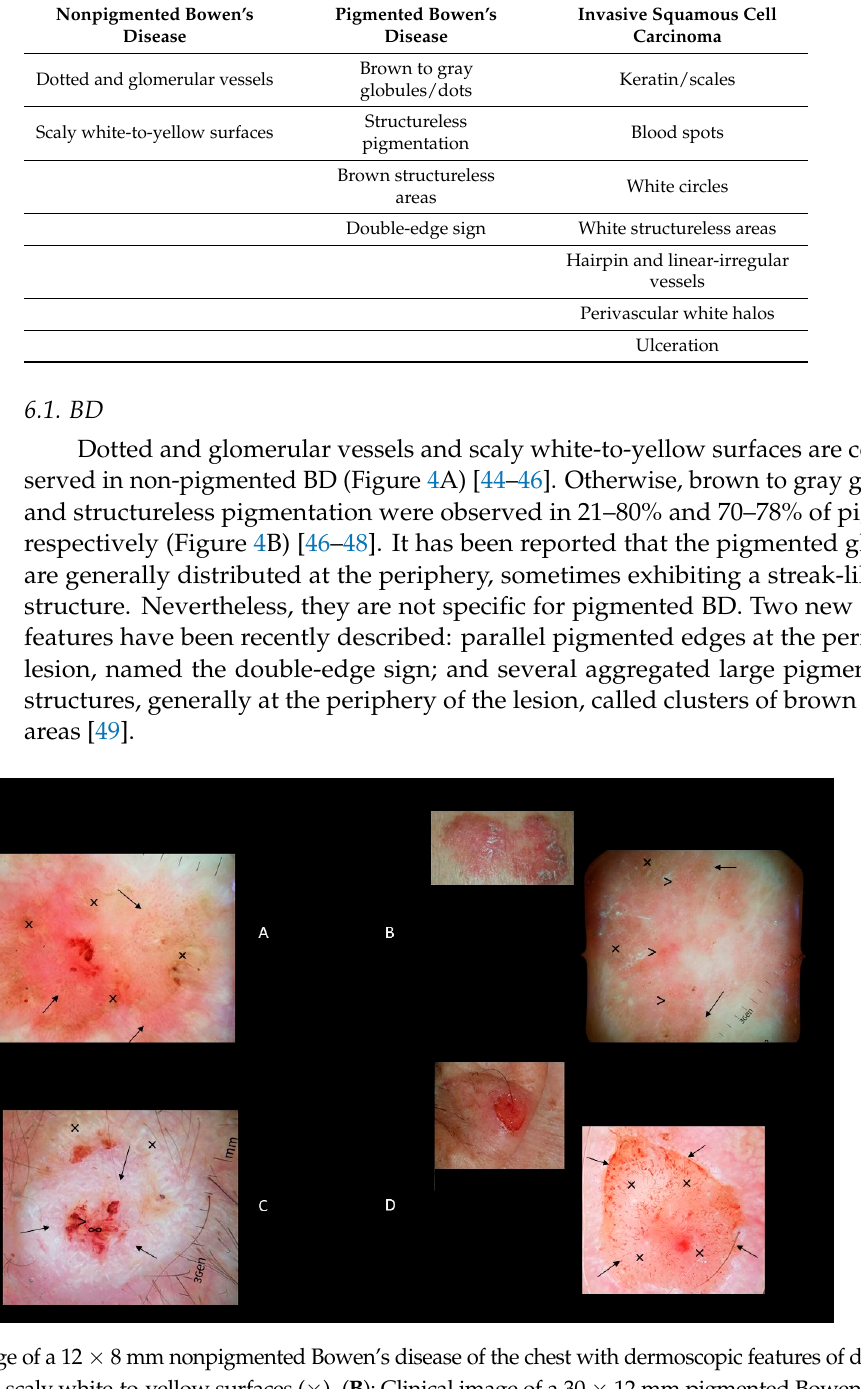
Table 2. Dermoscopic structures of cutaneous squamous cell carcinoma (cSCC) [44].